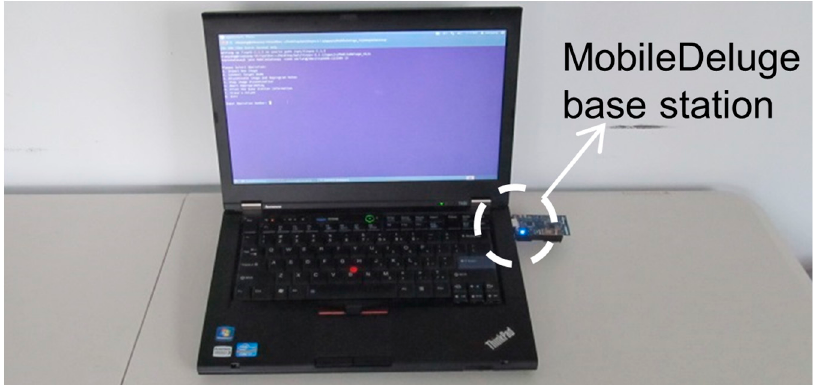
Figure 14. MobileDeluge, a hand-held mobile mote reprogramming tool.